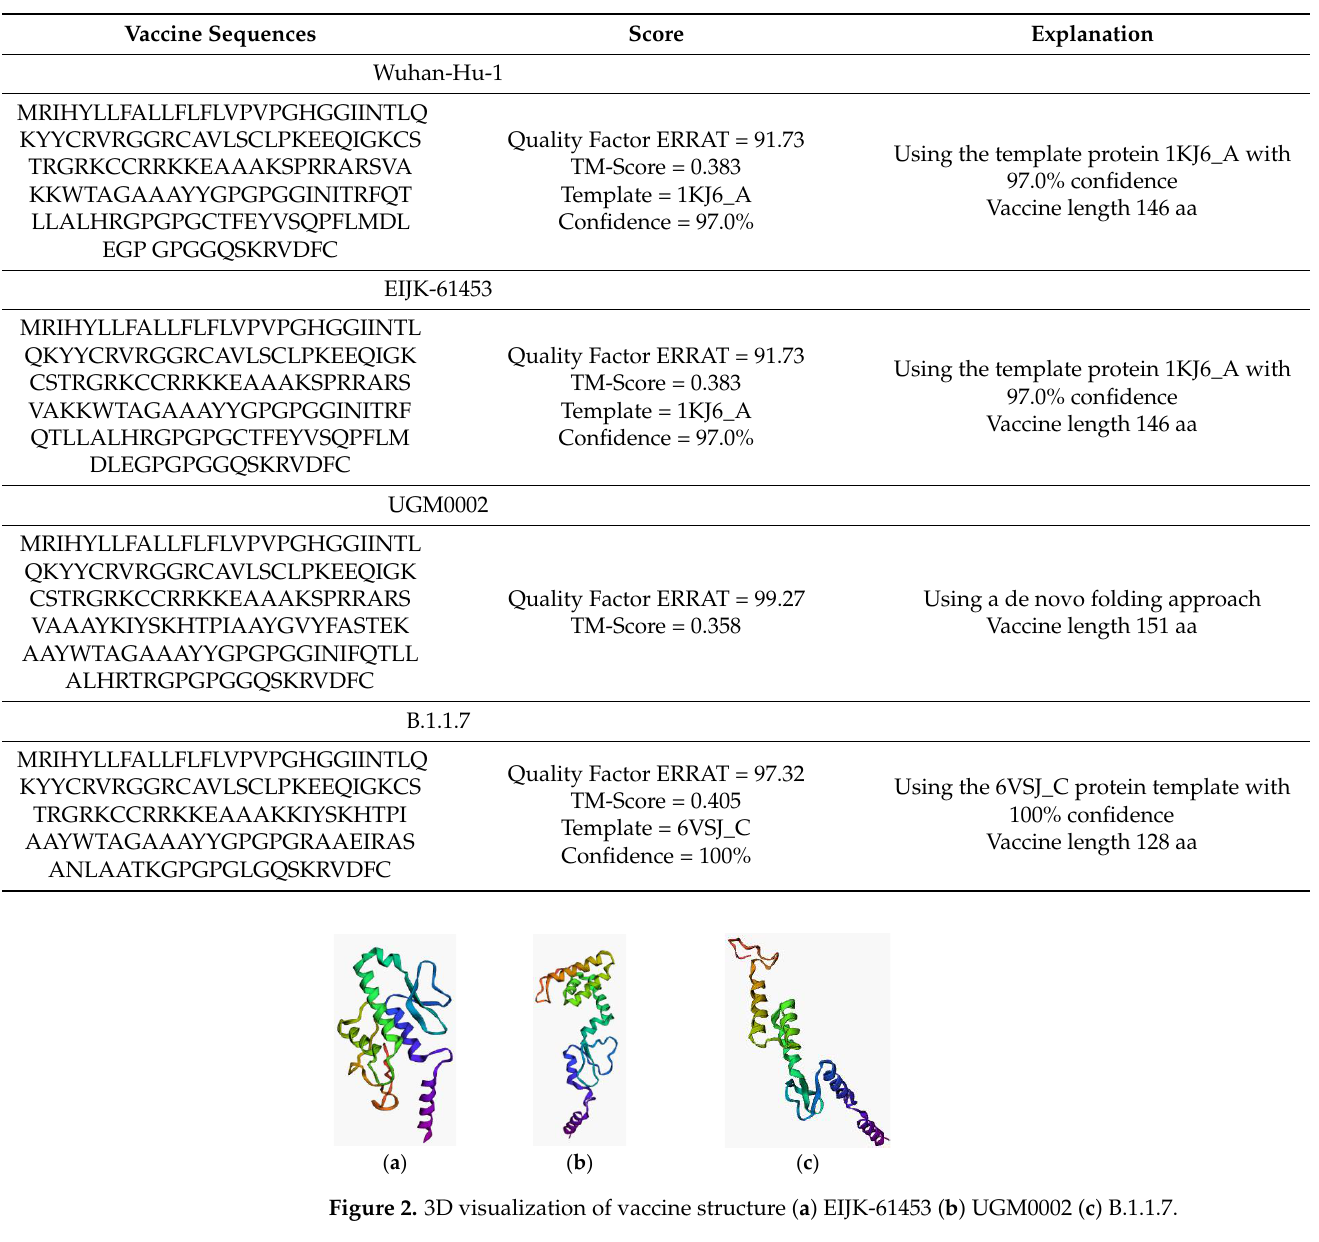
Figure 2. 3D visualization of vaccine structure ( a ) EIJK-61453 ( b ) UGM0002 ( c ) B.1.1.7.